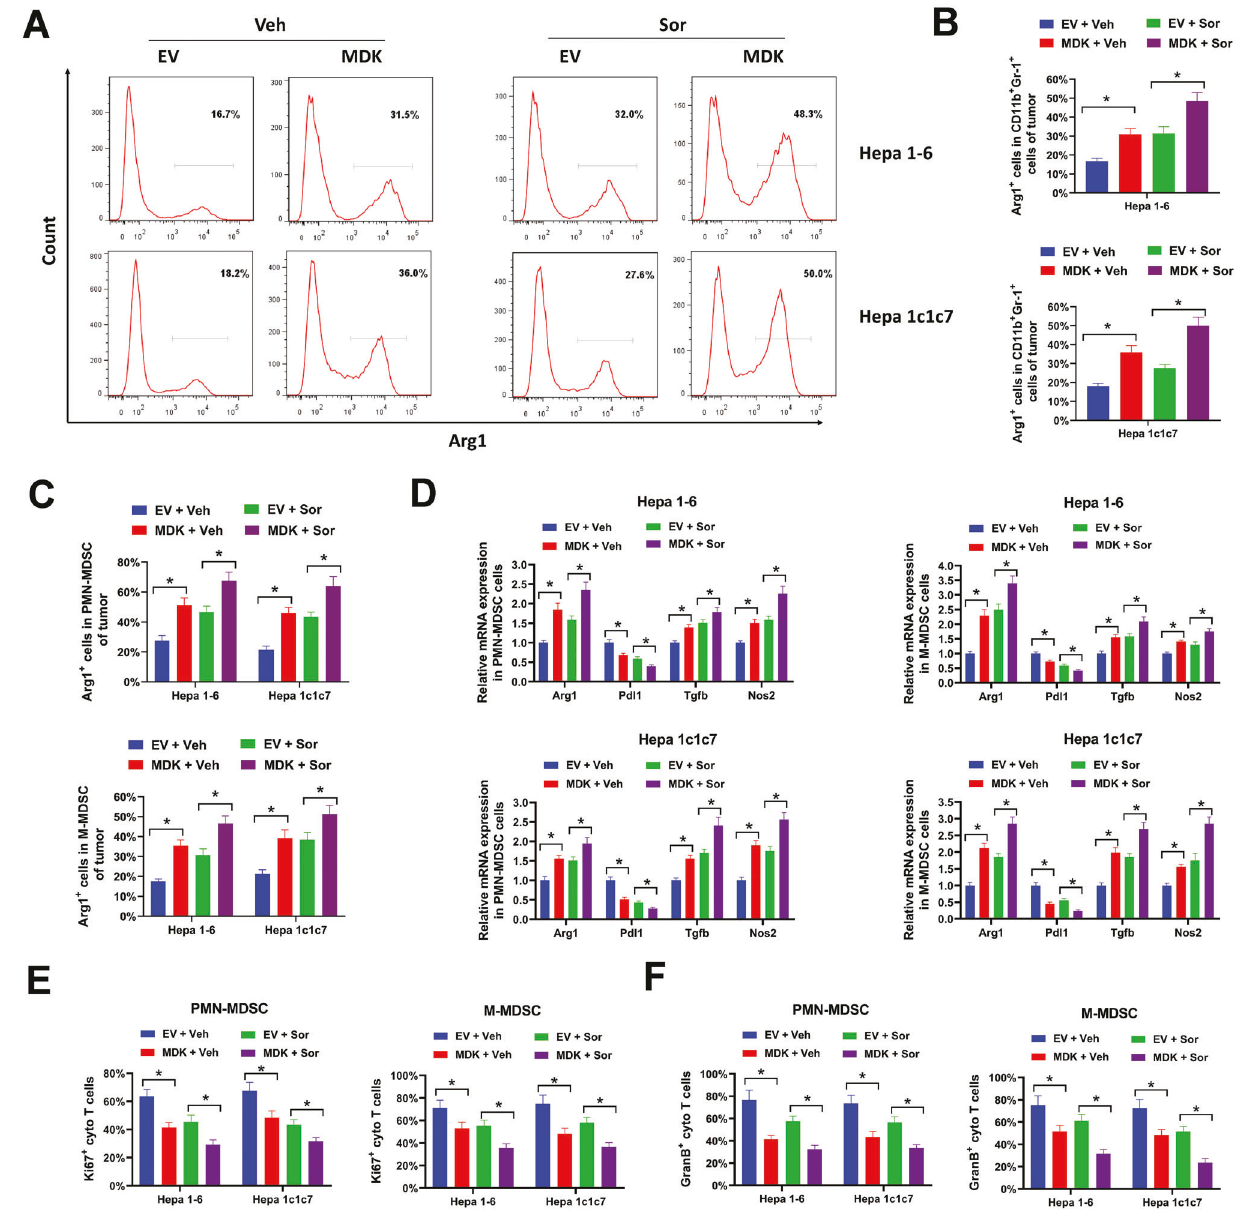
with sorafenib (Sor) or vehicle control (Veh) for three weeks. A-C, Arg1 + cells in in fi ltrating CD11b + Gr-1 + subset ( A – B ) and MDSCs subset ( C ) of orthotopic Hepa 1-6 and Hepa 1c1c7 tumors were evaluated by fl ow cytometry. D Relative expression of Arg1, Pdl1, Tgfb and Nos2